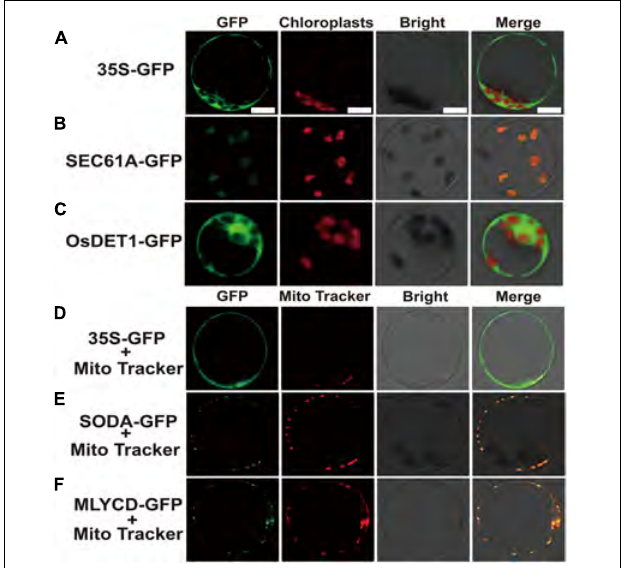
FIGURE 10 | Confocal microscope observation of subcellular localization with green fluorescent protein (GFP) fusion organelle markers in rice protoplasts. Subcellular localization of negative control (A) , SEC61A (B) and OsDET1 (C) . Negative control (D) , SODA-GFP (E) and MLYCD-GFP (F) co-localized with mitochondria tracker. GFP, Take photographs under the 390-nm excitation light, Bright: Take photographs under the bright light. Scale bar = 10 µ